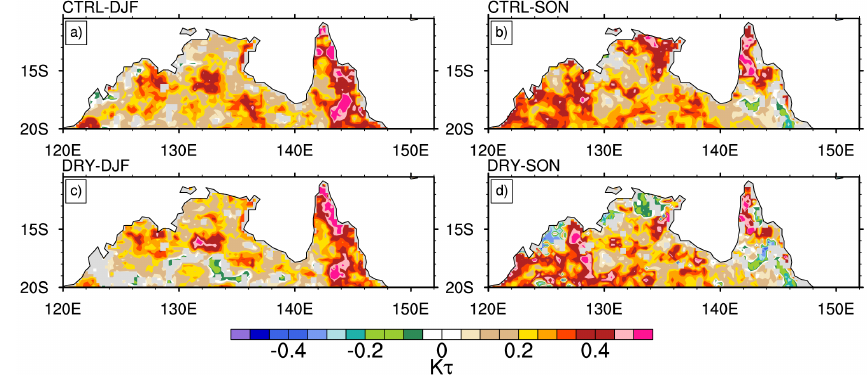
Figure 9. The ensemble median Kτ correlation metric between the morning root zone soil moisture (SM rz ) and the afternoon computed LCL from (a) CTRL over DJF, (b) CTRL over SON, (c) DRY over DJF, and (d) DRY over SON. The black outlined squares in (a–d) denote the values from the Howard Springs flux tower site. Only statistically significant (95% confidence level) results are shown in (a–d)